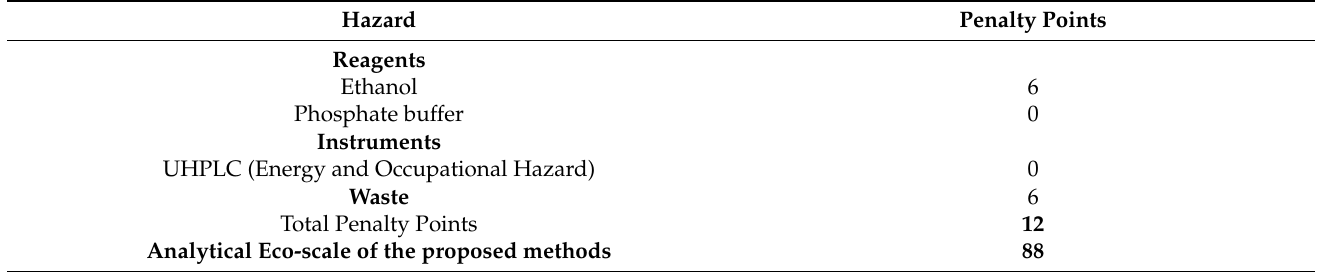
Table 5. Penalty points for the suggested chromatographic method.